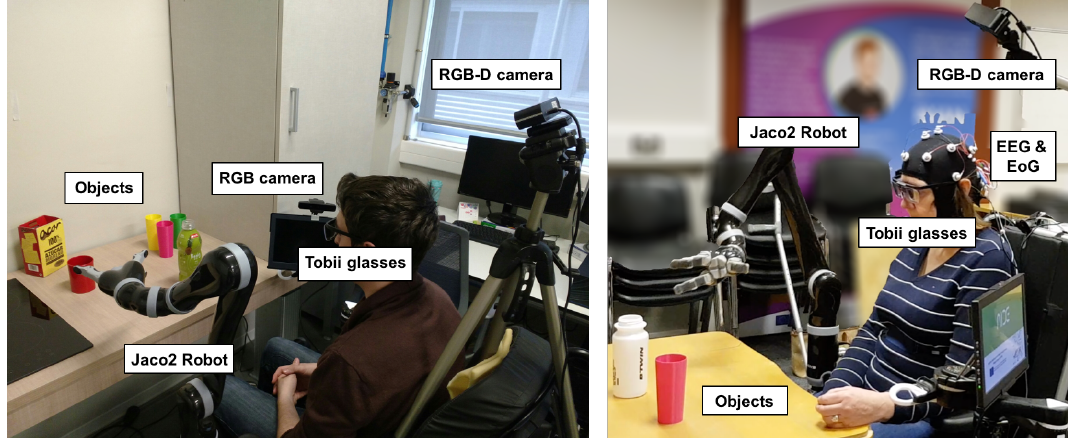
Figure 1. AIDE system integrates three different hardware modules: (i) a full-arm robotic exoskeleton or a Jaco2 robot; (ii) multimodal interfaces, consisting of a pair of gaze-tracking glasses (Tobii glasses) and a hybrid brain–computer interface (BCI) based on electroencephalography (EEG) and electrooculography (EOG); and (iii) context recognition sensors: a RGB-D camera to locate the object’s pose and a camera to compute the user’s head and mouth